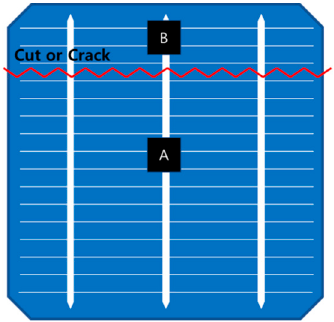
Figure 2. Horizontal cut of a c-Si solar cell.